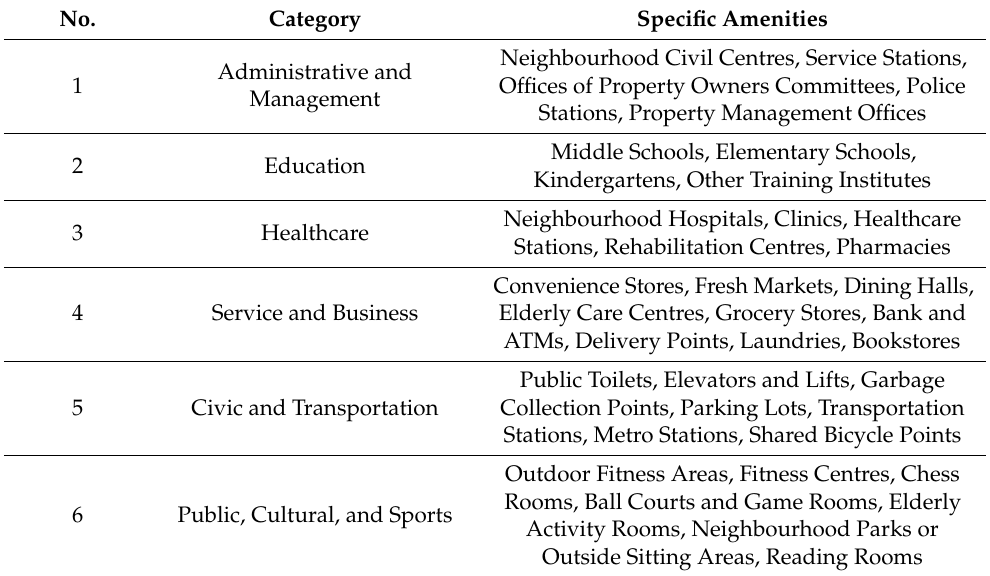
Table 1. Shortlist categories and specific